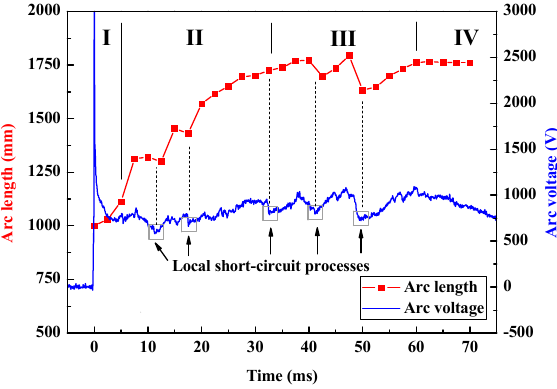
Figure 6. Variation of arc length and voltage with time ( L gap = 1000 mm).